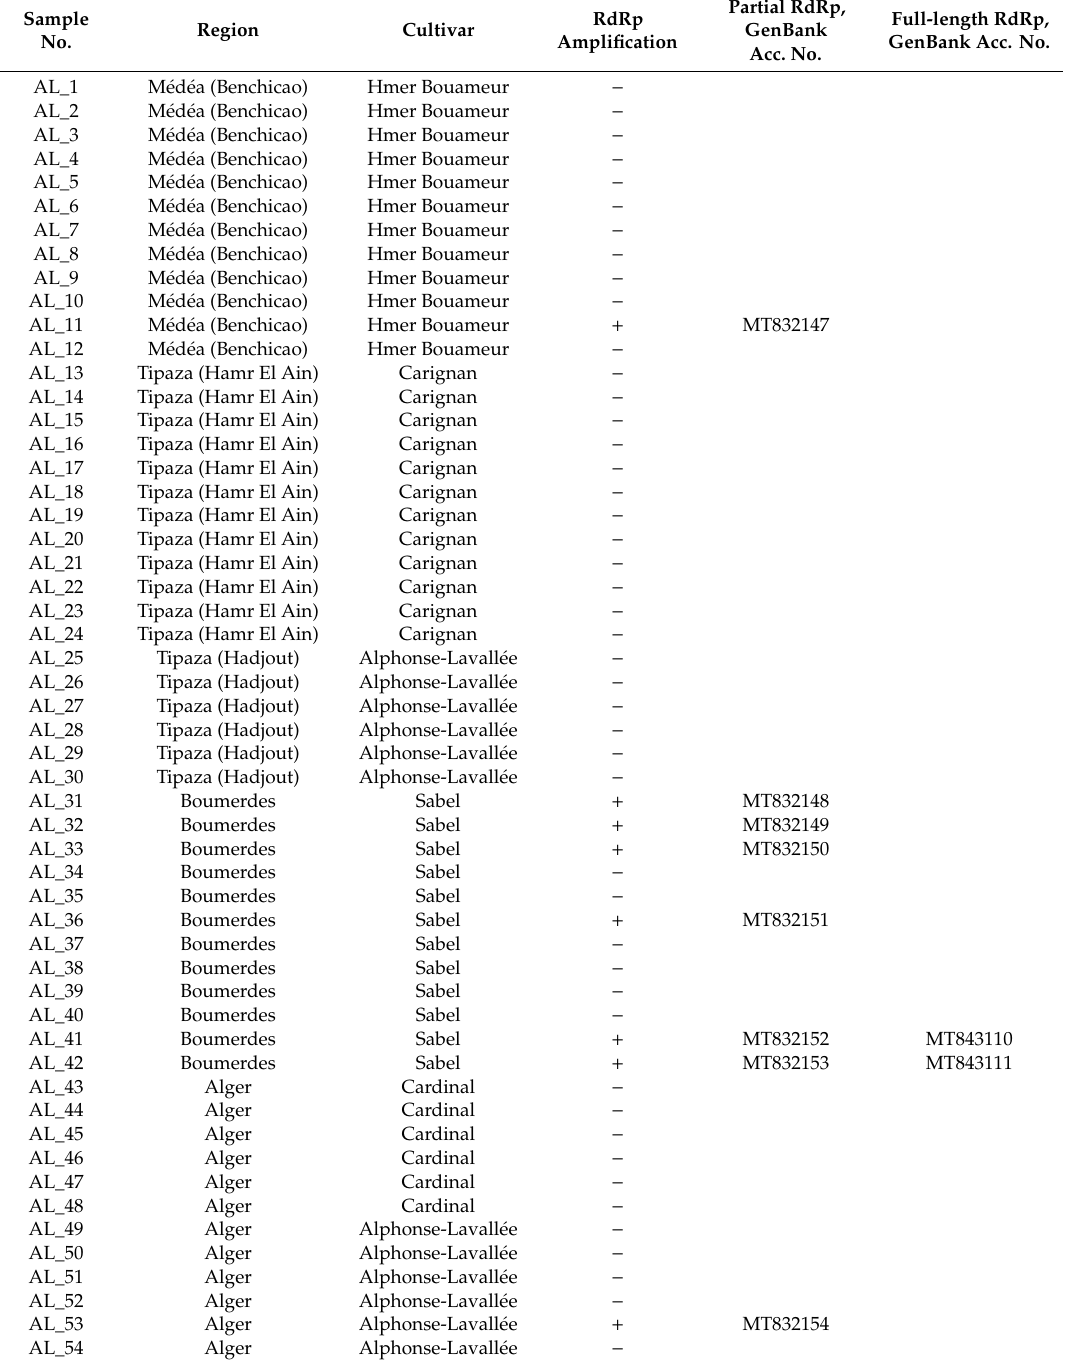
Table 2. Results of the Grapevine Pinot gris virus (GPGV) detection. Sample